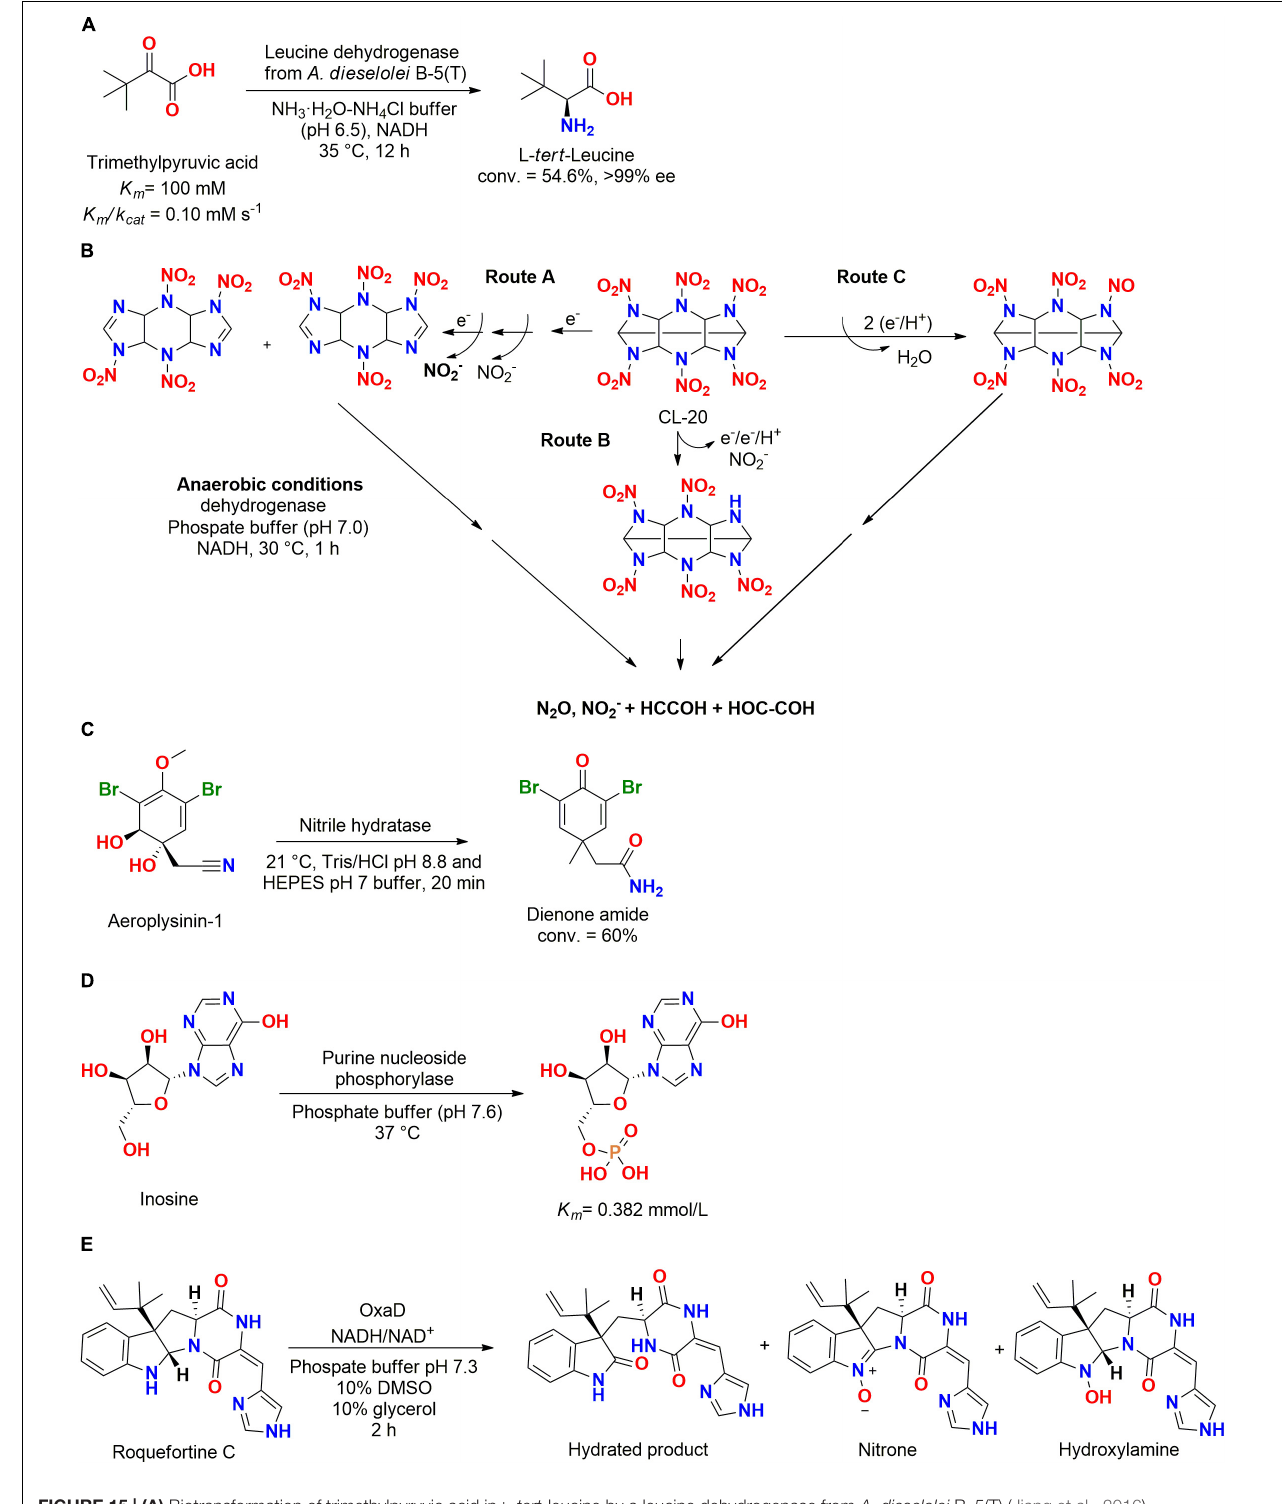
FIGURE 15 | (A) Biotransformation of trimethylpyruvic acid in L - tert -leucine by a leucine dehydrogenase from A. dieselolei B–5(T) (Jiang et al., 2016). (B) Biotransformation of CL-50 by a dehydrogenase obtained from Clostridium sp. EDB2 (Bhushan et al., 2005). (C) Biotransformation of aeroplysinin-1 by a nitrile hydratase into a dienone amide antibiotic (Lipowicz et al., 2013). (D) Phosphorylation of the nucleotide inosine by purine nucleoside phosphorylase enzyme from Pseudoalteromonas sp. XM2107 (Wang et al., 2010). (E) The use of the flavin-dependent nitrone synthase OxaD from the fungus P. oxalicum F30 for roquefortine C biotransformation (Newmister et al.,